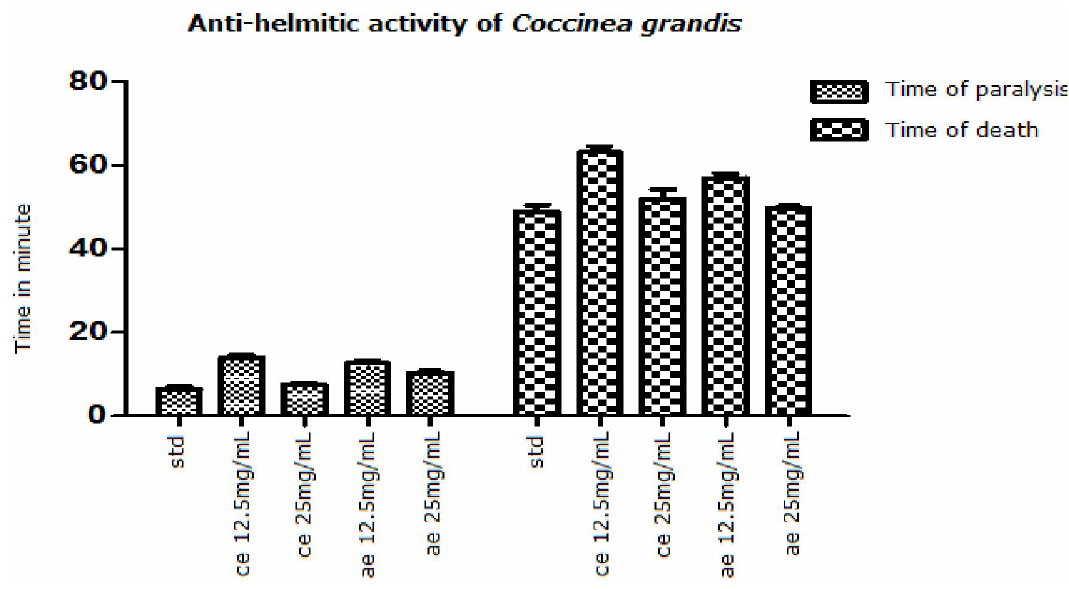
Figure 2. Evaluation of Antihelmintic activity Coccinea grandis Values are expressed as mean ± SEM (n